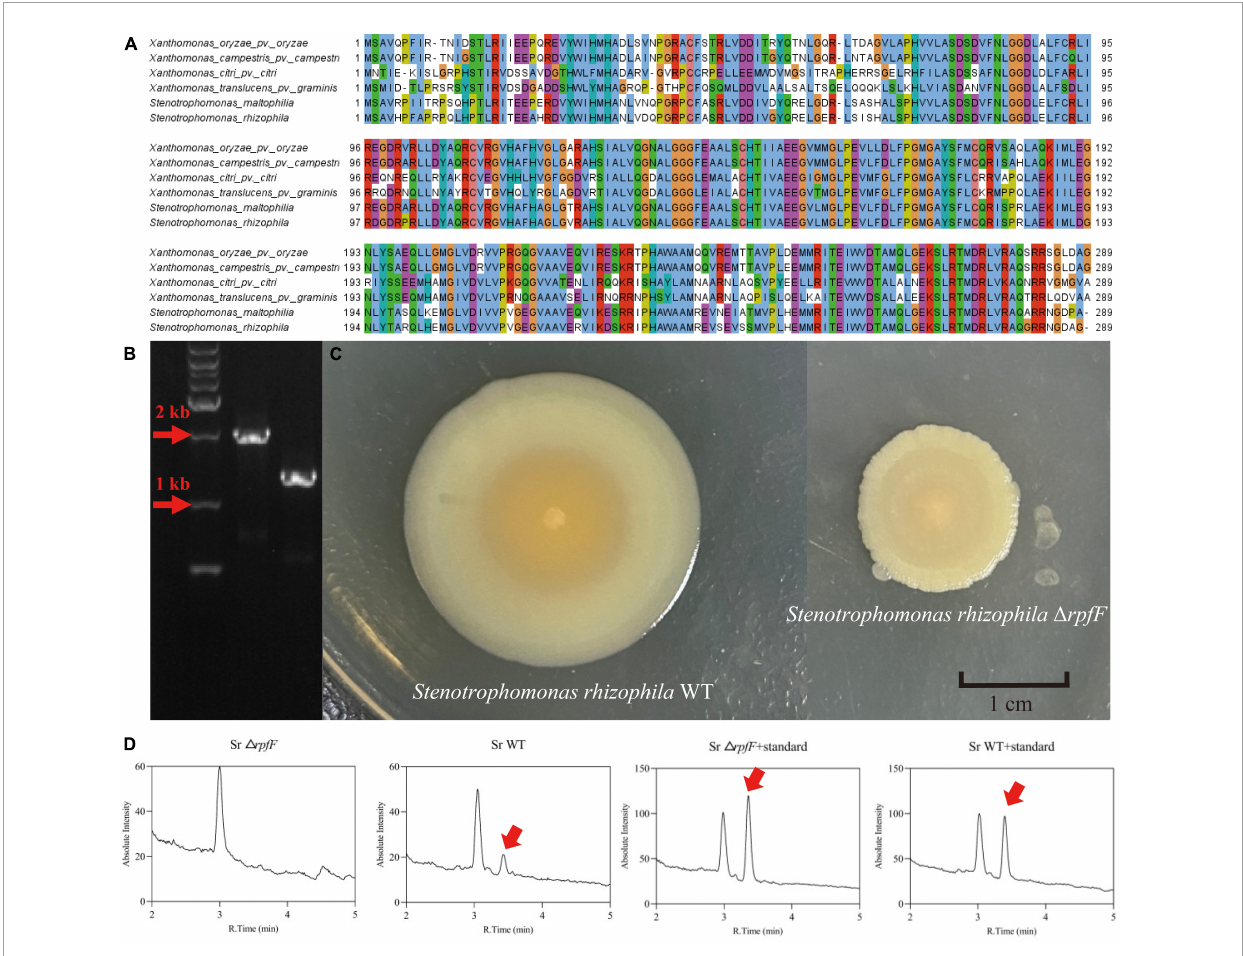
FIGURE1 (A) Jalview-visualization of the multiple sequence alignment of the RpfF amino acid sequences in the selected repertoire of bacterial species. (B) Agarose gel validating the knockout of the rpfF gene, DNA maker (lane 1), S. rhizophila WT (lane 2), S. rhizophila (cid:49) rpfF (lane 3). (C) Colony morphology of S. rhizophila WT and (cid:49) rpfF strains grown on LB solid medium for 1 week. (D) Representative MRM (multiple-reaction monitoring) chromatogram of the S. rhizophila WT and (cid:49) rpfF samples and corresponding DSF standards; the arrows point to the DSF